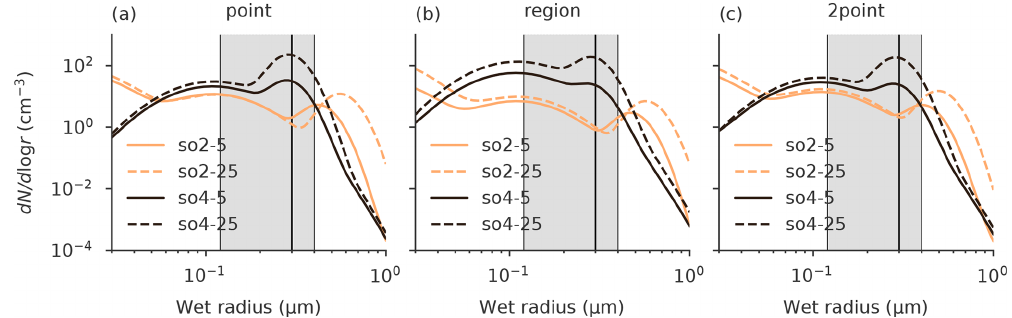
Figure 10. Global mean aerosol size distributions focusing on AM − SO 4 and coarse mode sulfate (CM − SO 4 ) particles at 62hPa, which is the central level of the injection layer, for the ECHAM simulations of the point injections (a) , the region injections (b) , and the 2point injections (c) . The grey bar marks the size range in which the backscattering efficiency of an aerosol particle with a given wet radius is at least 70% (i.e., 0.12–0.40µm) of its maximum value, which is achieved for aerosols with a wet radius of 0.30µm and marked by a thick solid black line (Dykema et al.,